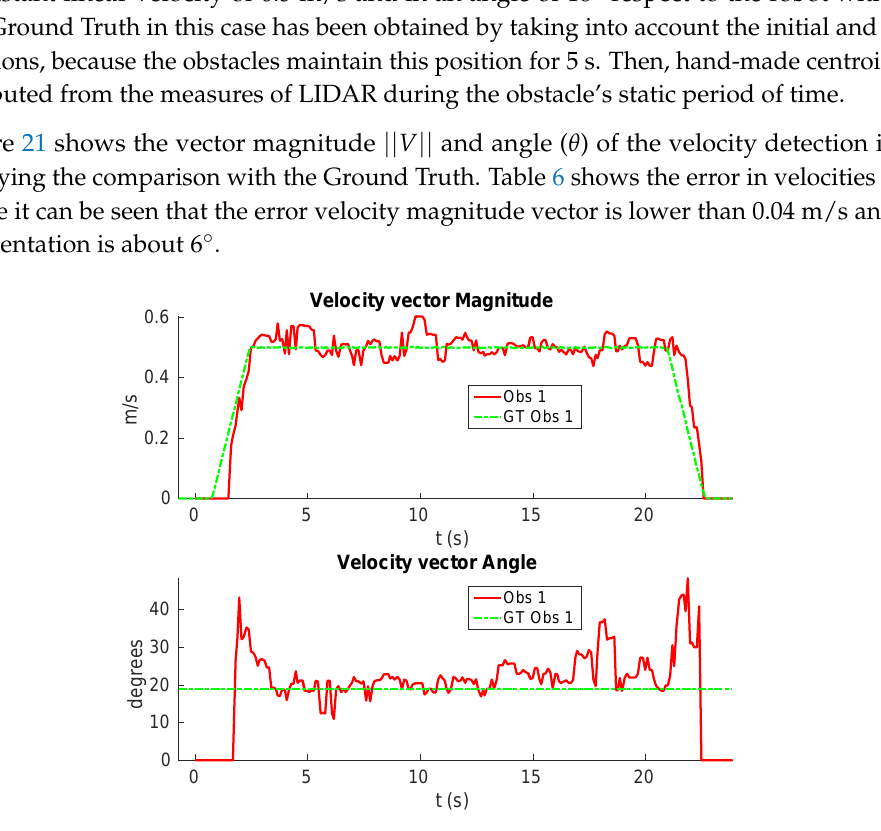
Figure 21. Real scenario 5—Results: Angle and Magnitude vectors. Table 6. Real scenario 5—Errors in velocities